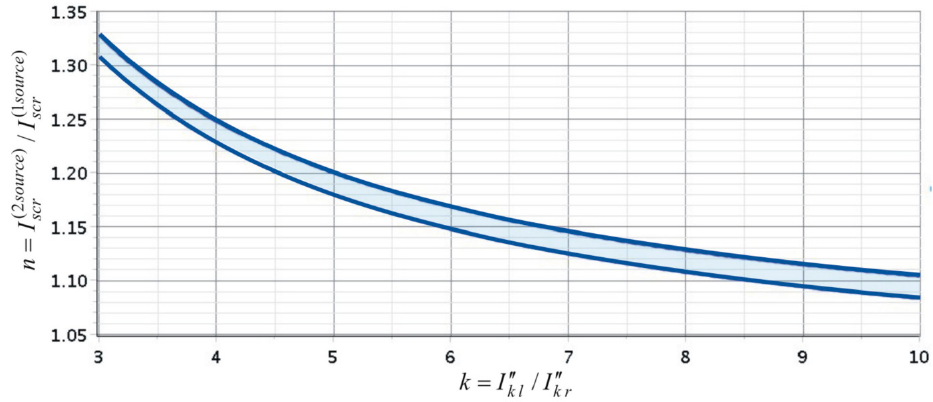
Figure 7. Dependence of the ratio between the value of the current obtained using the simulation in MATLAB Simulink and the value calculated using the highly simplified method on the ratio of the symmetrical three-phase fault currents on the buses of each sources (WTGs).